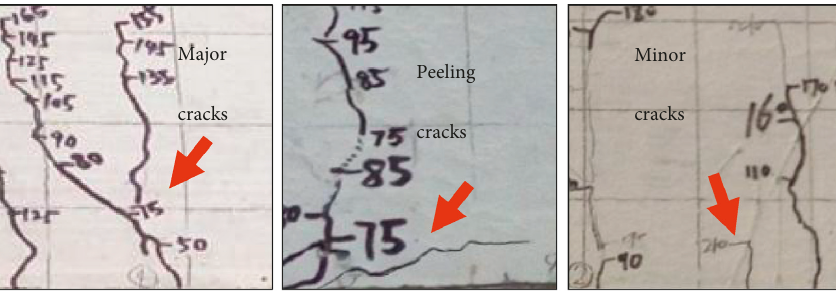
Figure 11: Classification of cracks.